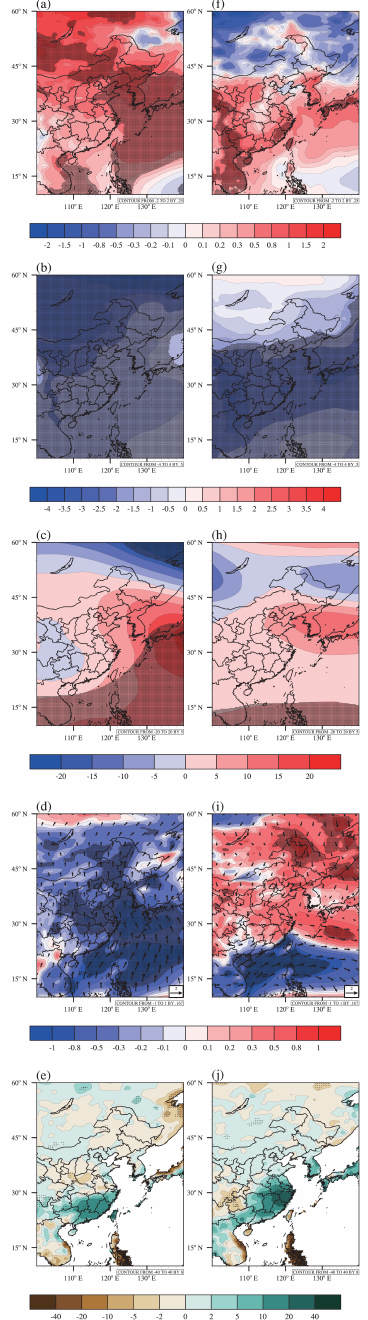
Figure 4. Winter mean changes in (a, f) air temperature at 2m (unit: K), (b, g) sea level pressure (unit: hPa), (c, h) geopotential height at 500hPa (unit: gpm), (d, i) wind averaged from 1000 to 850hPa (The arrows represent wind vectors and the contours repre- sent wind velocities, unit: ms − 1 ), and (e, j) precipitation (unit: mm) in response to the two types of El Niño. The left (a–e) and right (f–j) panels represent the differences averaged in 10 EP El Niño and 6 CP El Niño years, respectively, relative to the 1961–2013 climatologi- cal means. The dots indicate significance at the ≥ 90% confidence level from a t